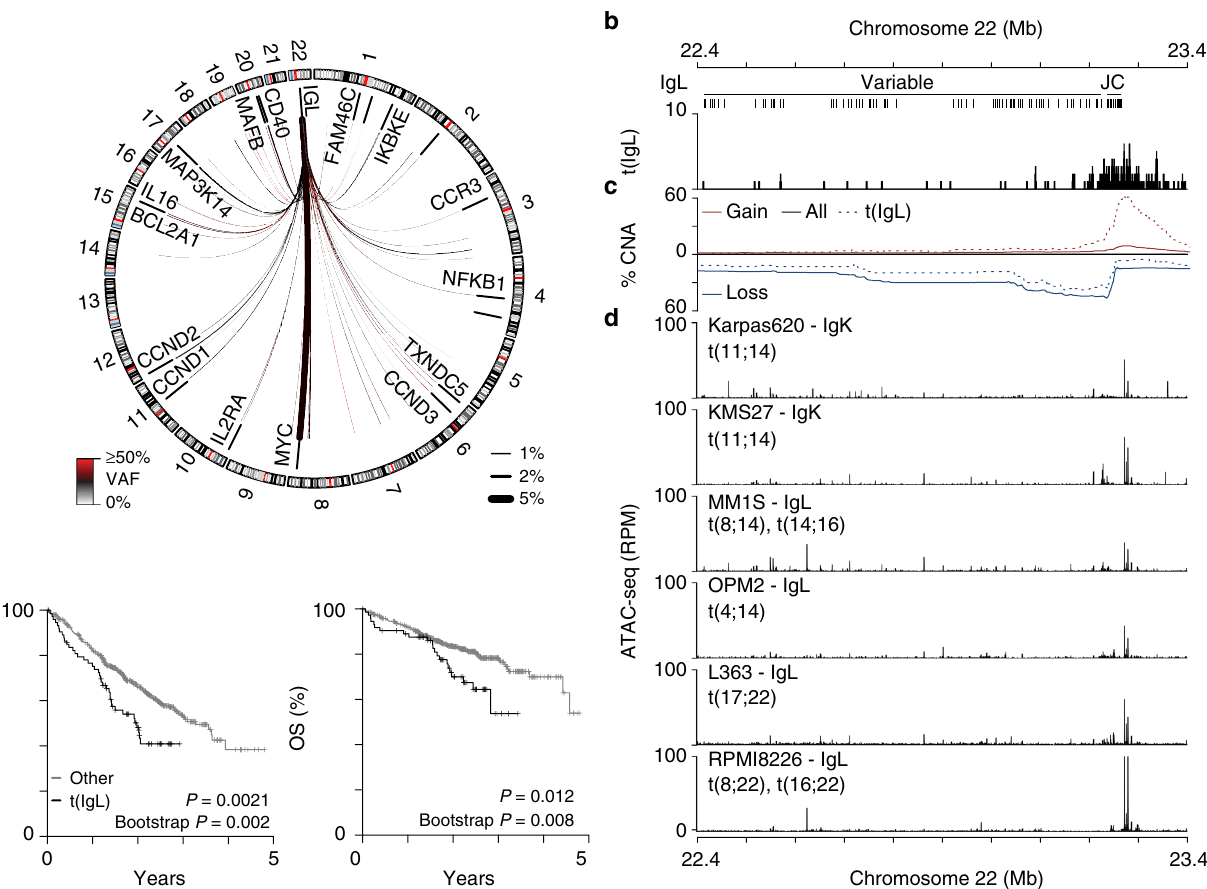
Fig. 4 IgL translocations portend poor prognosis. a Circos plot showing the repertoire of IgL translocations in newly diagnosed myeloma where line color and thickness denote variant allele frequency (VAF) and translocation frequency (keys bottom left and right). b Genome plot (GRCh37) of the IgL locus showing the variable, joining (J), and constant (C) regions and locations of translocation breakpoints. c The frequency of copy number gains (red) and losses (blue) in the entire cohort (solid line) and in t(IgL) samples (dashed line), and d ATAC-seq for 6 myeloma cell lines labelled with their light chain expression status and known translocations denoted. e Kaplan-Meier analysis of IgL translocated [t(IgL)] patients ( N = 78) as compared to non-t(IgL) ( N = 717) for progression-free (PFS; left) and overall survival (OS; right). P -values were calculated using a Cox proportional hazards Wald ’ s test or Bootstrapped based P-value with 1000 permutations based on the hazard ratio. Source data are provided as a Source Data fi